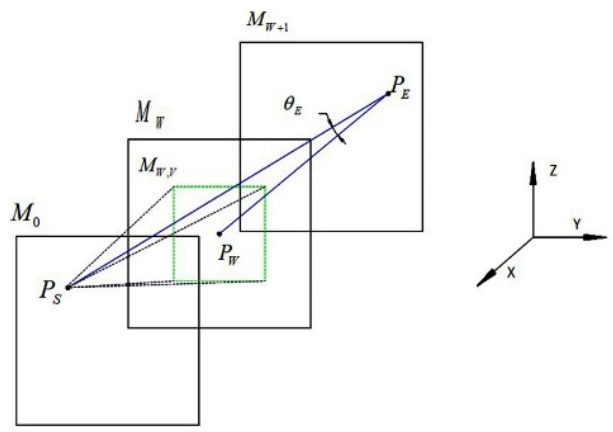
Figure 7. Angle parameter